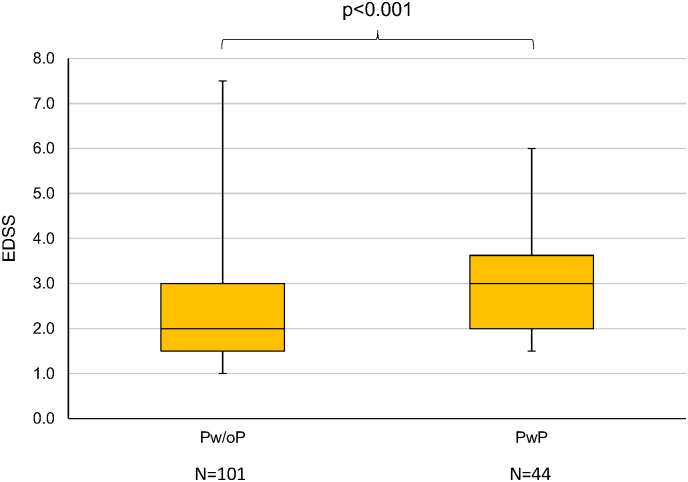
Comparison of EDSS scores between Pw/oP and PwP.Boxplot of the degree of disability of the patients stratified by the presence of polypharmacy according to the total number of medications taken (Pw/oP: N = 101; PwP: N = 44). The boxes mark the upper and lower quartiles of the EDSS scores per group. The medians are indicated by horizontal lines. The whiskers extend to the minimum and maximum values. PwP had, on average, a significantly higher level of disability than Pw/oP, as evaluated by EDSS (Mann-Whitney U test: p<0.001). EDSS, expanded disability status scale; N, number of patients; p, p-value; PwP, patients with polypharmacy; Pw/oP, patients without polypharmacy.